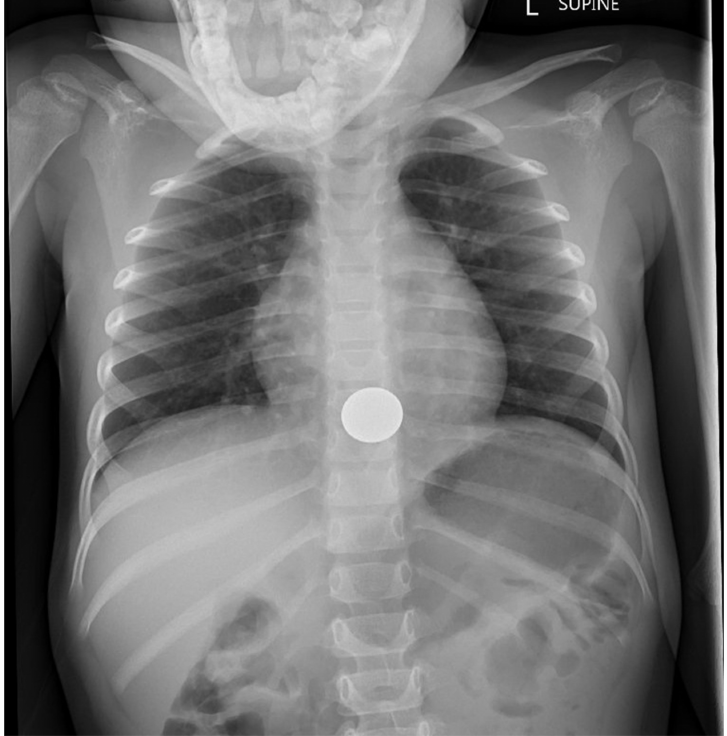
Figure 3. Chest radiograph showing coin lodged at lower esophageal sphincter (photo courtesy of Marcus Rivera,